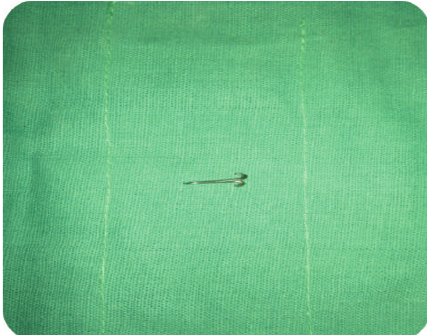
Figure 9: Clinical photograph of coronal build in relation to 51.